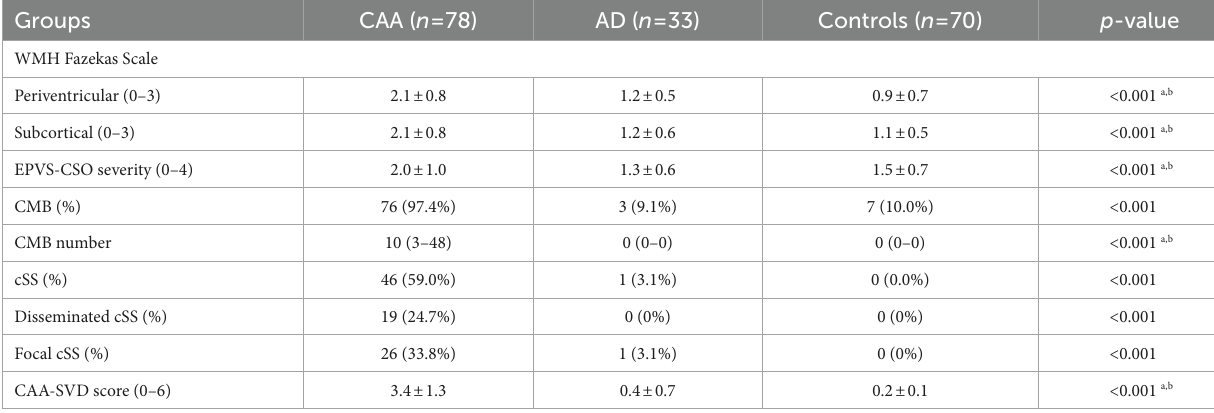
TABLE 2 Summary of MRI cerebral small vessel disease